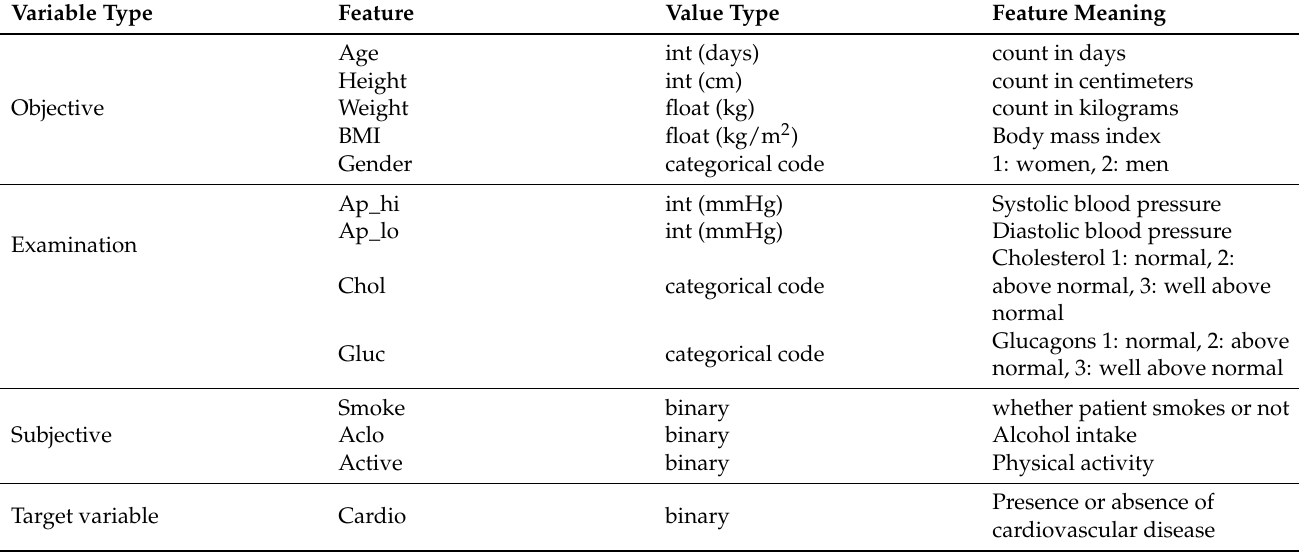
Table 1. Characteristics of the